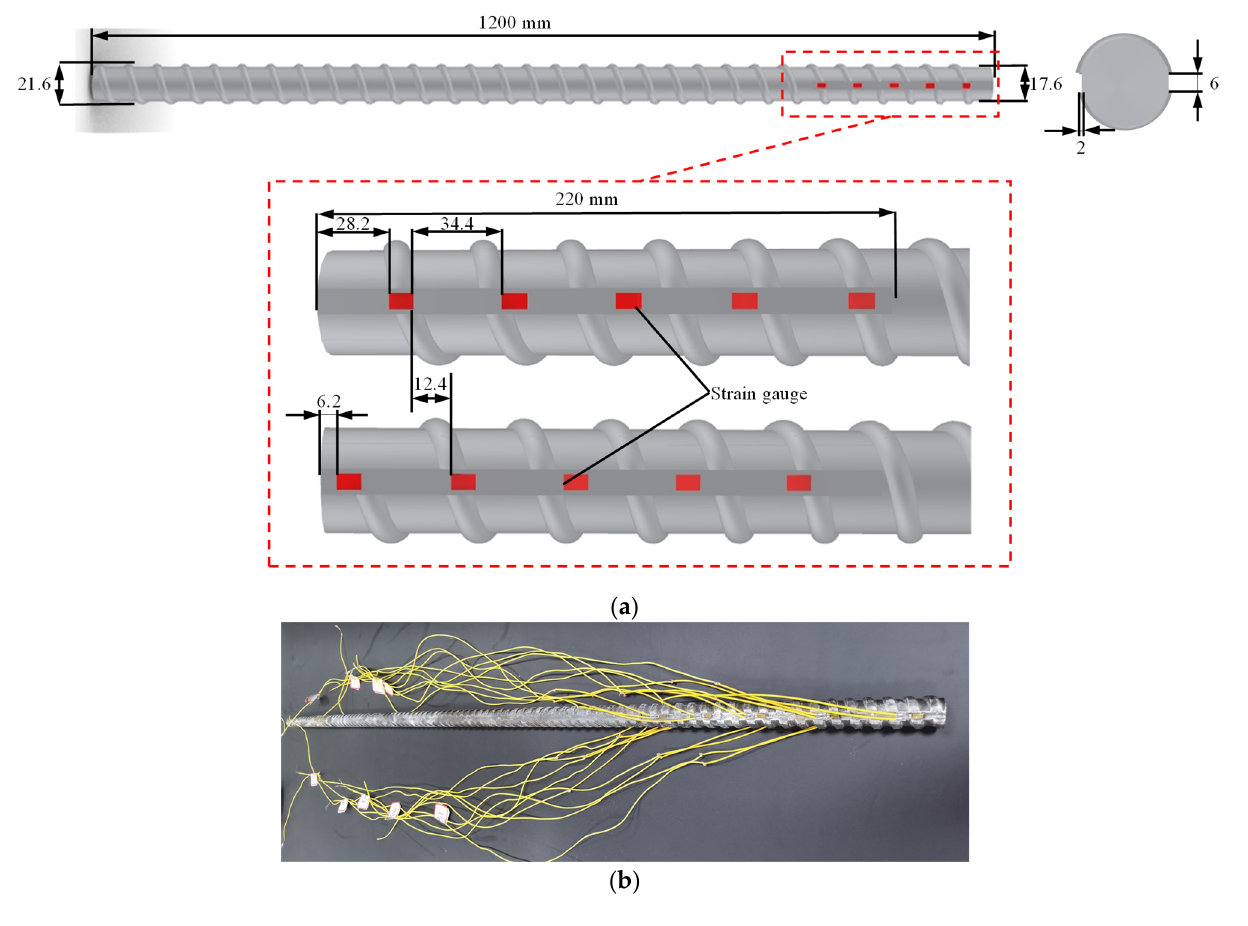
Figure 3. Force-measuring bolt: ( a ) layout of the bolt’s strain gauges; ( b ) completed force-measuring